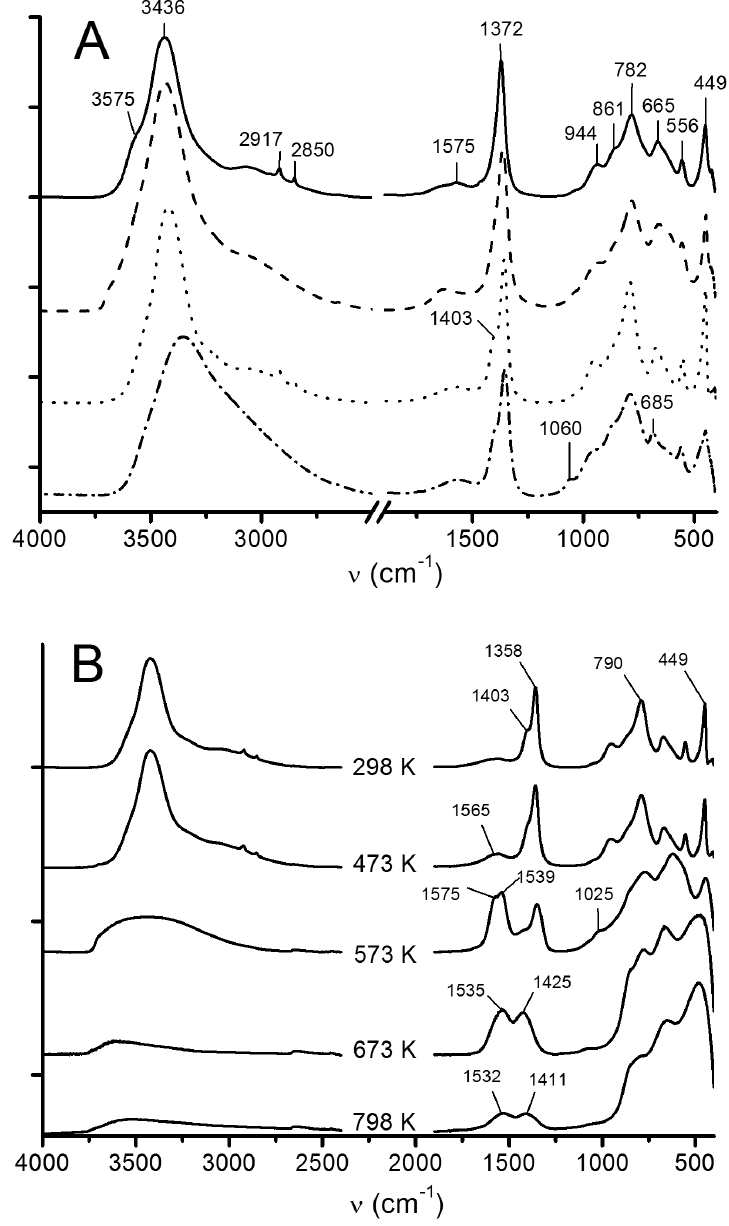
Figure 4. ATR-FTIR spectra of ( A ) different LDH particles with commercial reference (HT); and ( B ) after thermal decomposition of LDH-C particles. HT (–), LDH-OH (- - -), LDH-C ( · · · ) and LDH-U (– ·